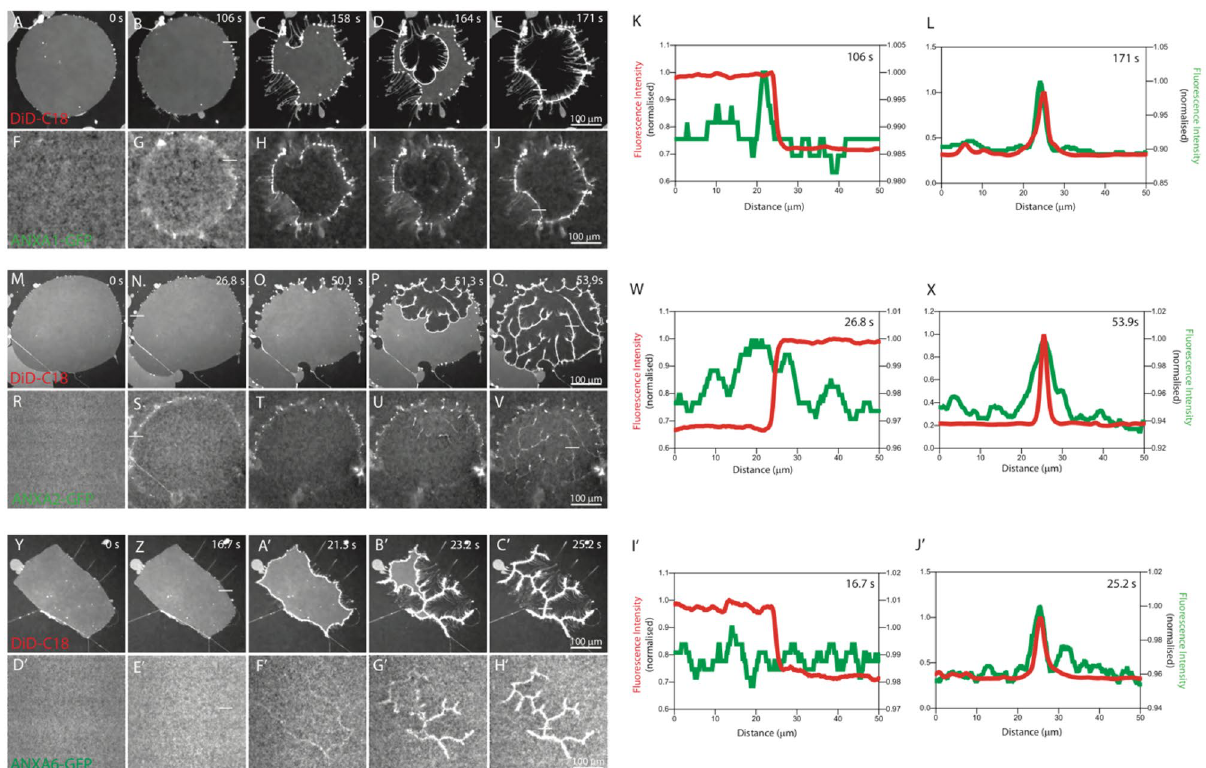
Figure 3. Localization of crosslinkers during membrane patch rolling. Response of non-vesicular membrane patches with open edges (DOPC/DOPS, 9:1 molar ratio) to exposure to annexins when 1:1 annexin mixtures of ANXA4 and ANXA1-GFP (DiD, A – E ; GFP, F – J ), ANXA4 and ANXA2-GFP (DiD, M – Q ; GFP, R – V ) and ANXA4 and ANXA6-GFP (DiD, Y – C ′ ; GFP, D ′ – H ′ )) are added to non-vesicular membrane patches with open edges (DOPC/DOPS, 9:1 molar ratio). Cross-sections taken on rolling onset (white line ANXA1, B , G , ANXA2, N , S , ANXA6, Z , E ′ ) show that maximum ANXA-GFP fluorescence intensity (green line) coincides with the membrane patch edge as defined by DiD fluorescence (red line) for ANXA1 ( K ) and ANXA2 ( W ) and has no maximum for ANXA6 ( I ′ ).Cross-sections taken on rollup completion (white line ANXA1, E , ANXA2, Q , ANXA6, C ′ ) show that maximum ANXA-GFP fluorescence intensity (green line) coincides with the rolled membrane as defined by DiD fluorescence (red line) for ANXA1 ( L ), ANXA2 ( X ) and ANXA6 ( J ′ ).